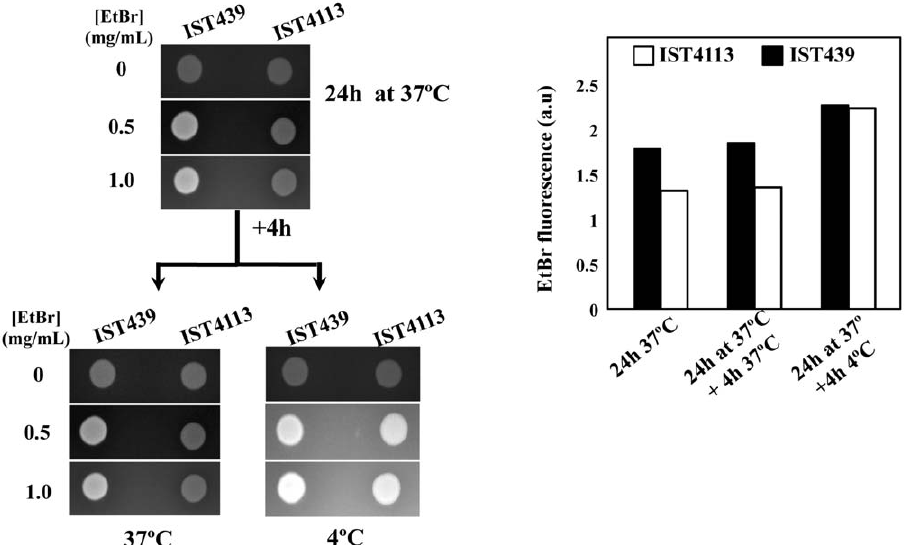
Figure 3. Indirect comparison of the active drug export capacity of IST439 and IST4113, based on the ethidium bromide screening agar method. Cells of the two clonal variants were harvested in mid-exponential phase of growth and spread, in duplicate, onto the surface of LB plates supplemented or not with ethidium bromide, as detailed in Materials and Methods. The plates were incubated for 24 h at 37 u C and the fluorescence values emitted by the cell mass present in each plate were quantified. One set of plates was left to grow for an additional period of 4 h at 37 u C while the other set was transferred to 4 u C, a temperature at which the activity of MDR pumps is significantly reduced. The results obtained are representative of at least three independent experiments.